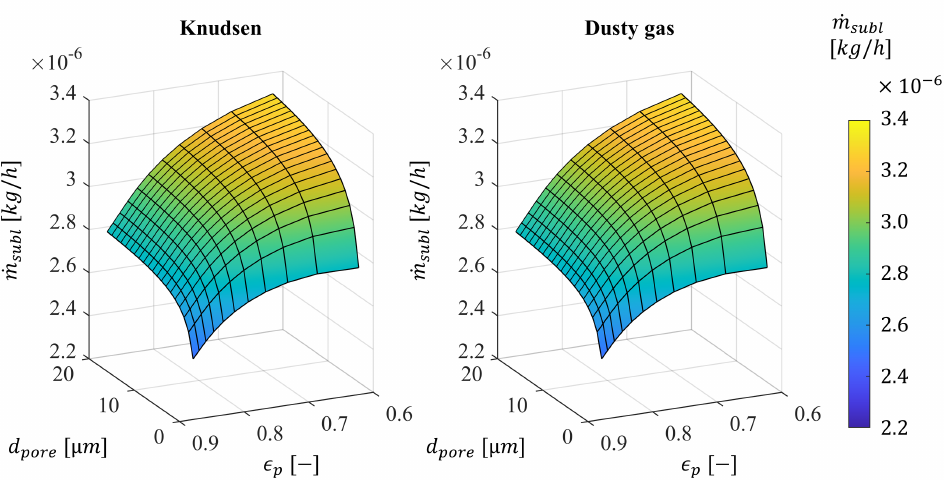
Figure 6. Averaged vapor mass flow during the freeze-drying process, modeled by Knudsen diffusion and the dusty gas approach as a function of mean pore diameter and porosity Again both models show consistent results. It can be observed here that an increasing porosity of the sample reduces the vapor flow significantly. The optimum for both models is shown with 3.3 mg h − 1 at a pore size of 20 µm and an accessible porosity of 0.61 which corresponds to a sample where no gas was injected. With this configuration the optimal amount of vapor can be removed from the system during primary drying. It shows that the influence of porosity is increasing with increasing pore diameter since the freeze-drying process gets increasingly limited by the heat transfer. On the other hand, it shows that an increasing pore diameter has higher influences at low porosities of 60% in comparison to high porosities where the system is anyways limited by the heat transfer. At porosities of almost 0.9 a change in pore diameter from 10 to 20 µm does not significantly change the results, while a change from 1 to 10 µm has an impact. The highest limitations are observed at small pore diameters of 1 µm and high porosities of almost